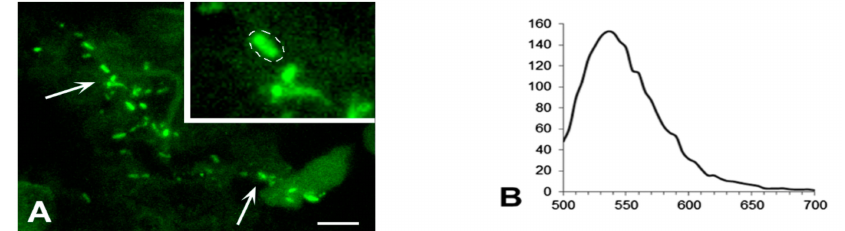
Figure 1. Immunolabelling of M. tuberculosis in the lung tissue of mice, infected with the strain H37Rv. ( A ) The colony of M. tuberculosis (arrows). Inset: High magnification of the bacteria, selected for measuring of an emission spectrum (dotted line). Scale bar = 5 µ m. ( B ) The emission spectrum of the selected bacteria is similar to the spectrum of Alexa-488. The abscissa shows emission wavelength, nm; the ordinate shows relative